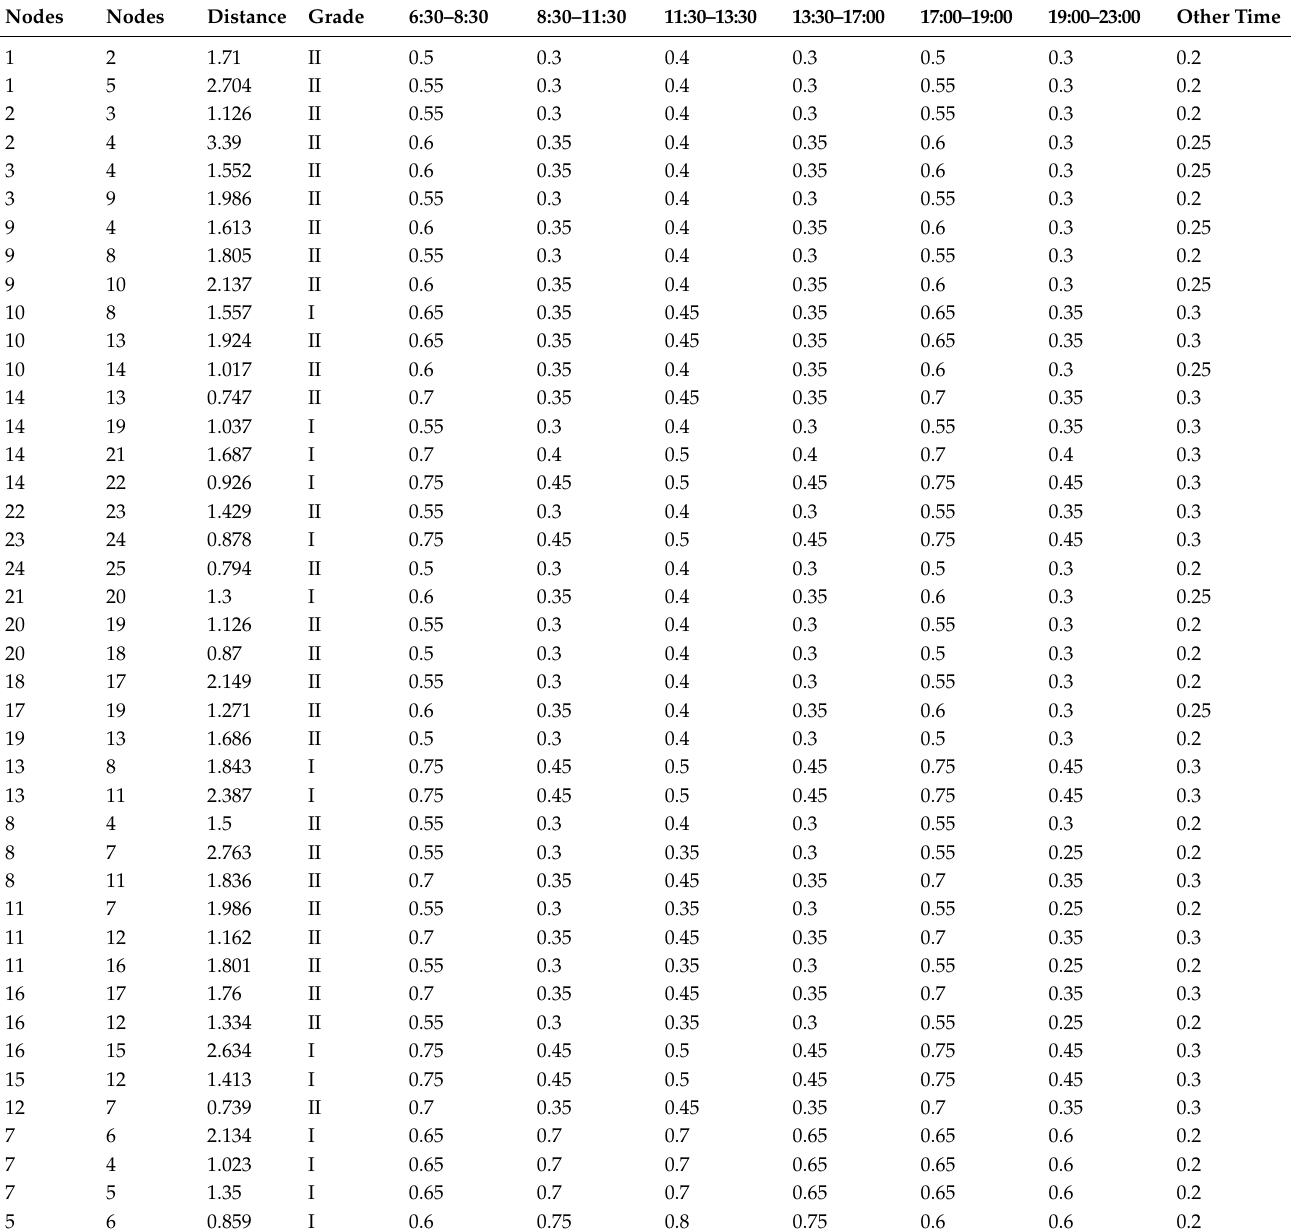
Table A1. Road network parameters and saturation